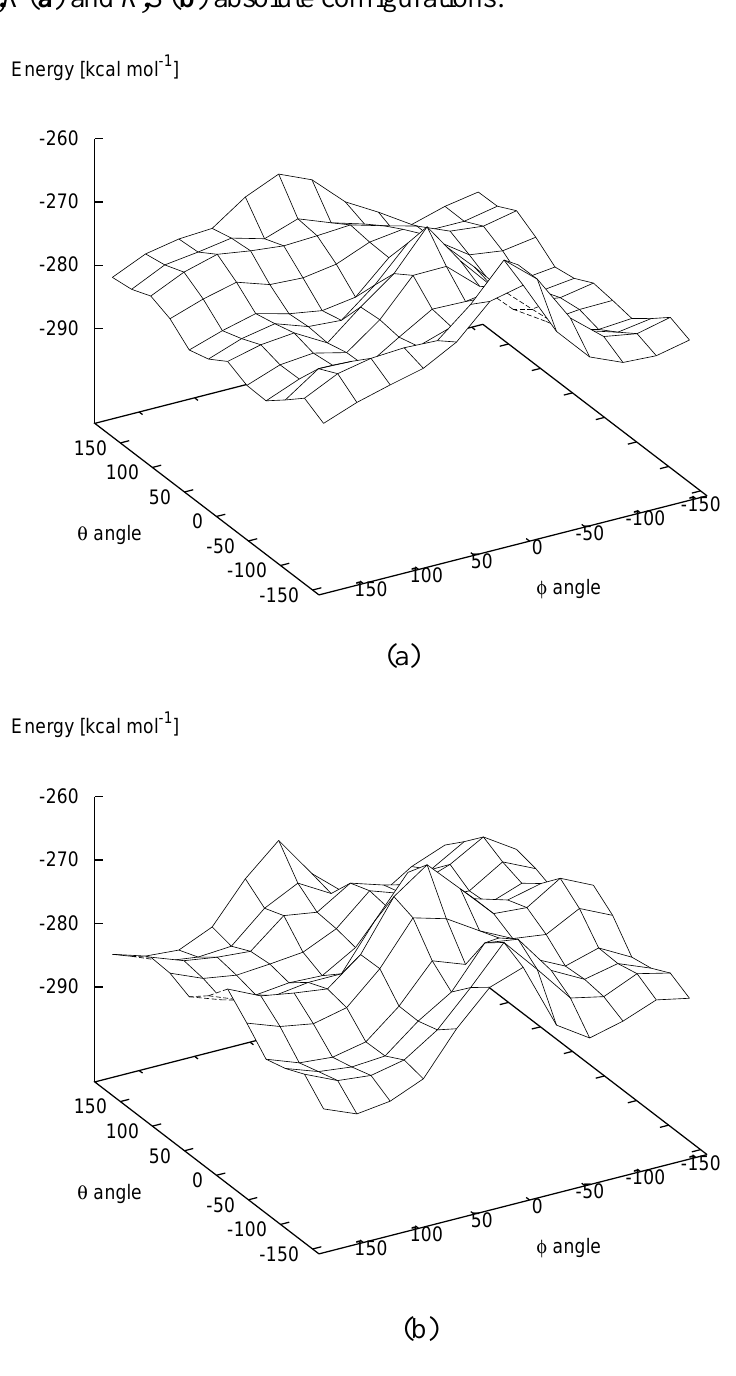
Figure 5 . Potential energy surface as a function of the θ and φ angles of quinomethide 7 with the R,R ( a ) and R,S ( b ) absolute